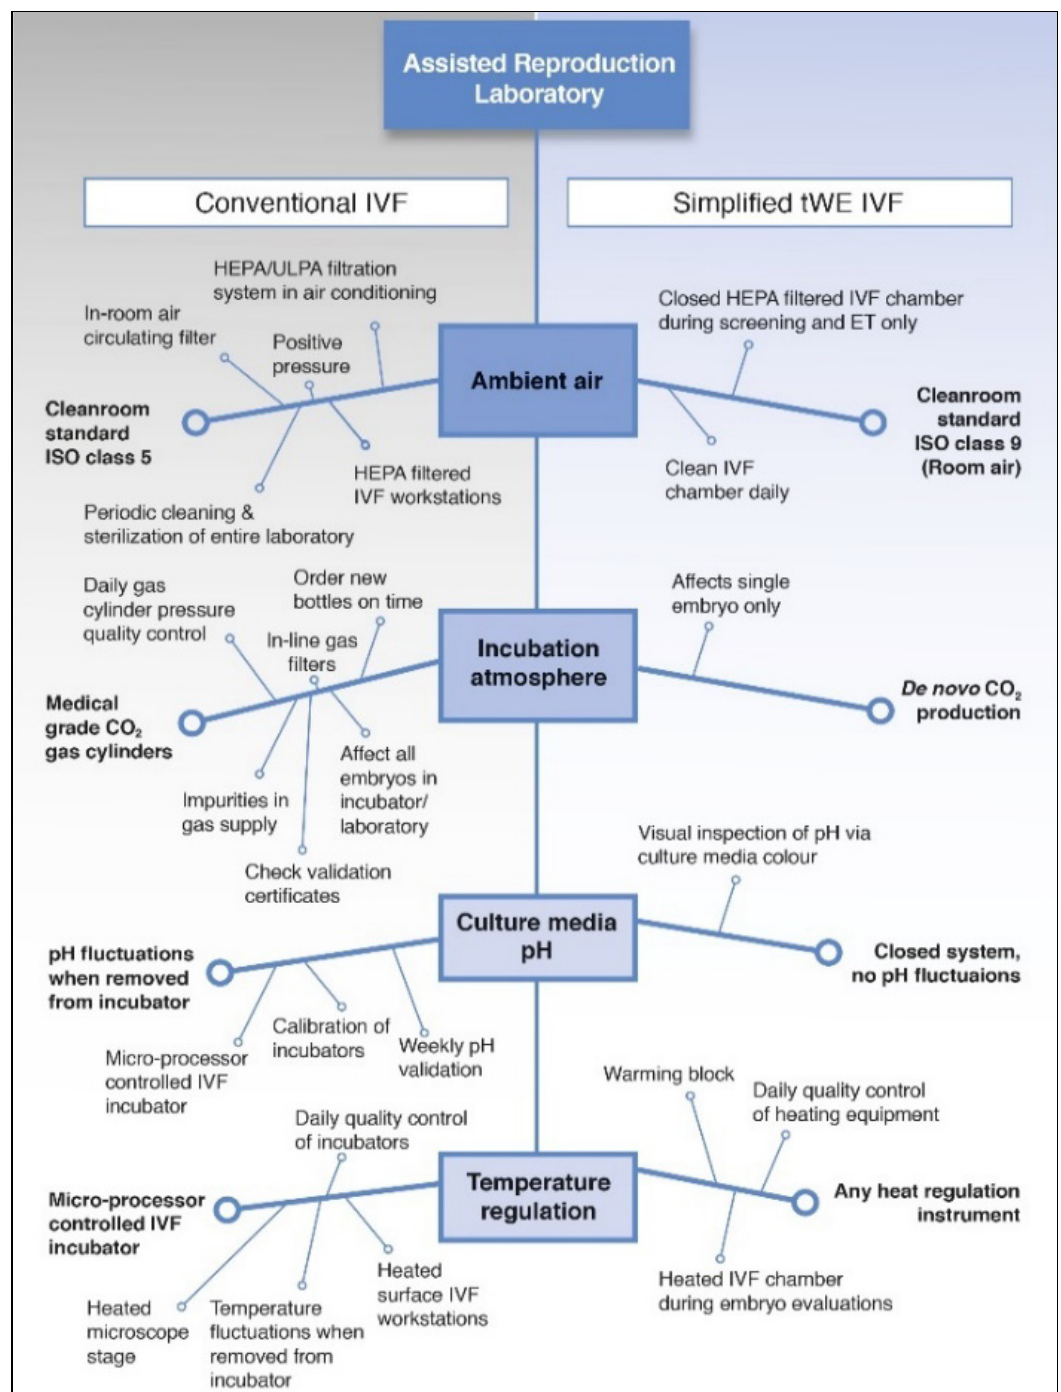
Figure 2. Overview of the differences in essential prerequisites to ensure optimal laboratory quality between a regular IVF and SCS laboratory. The main difference is that in conventional IVF we use incubators with continuous gas regulation, whereas the simplified culture is in a closed tube that is pre-gassed to ensure optimal environment. The simplified culture system therefore only needs to be kept warm and doesnot need a gas supply to be connected to the